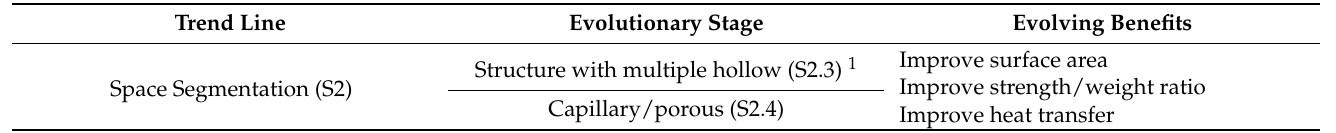
Table 2. Evolutionary benefits of the Space Segmentation trend (partially presented).